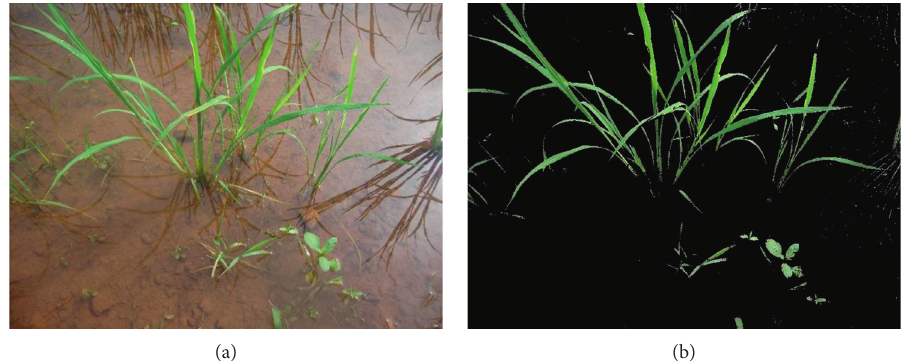
Figure 4: (a) Image taken at a distance of 0.16m from the ground using the Sony camera and (b) the corresponding background subtracted